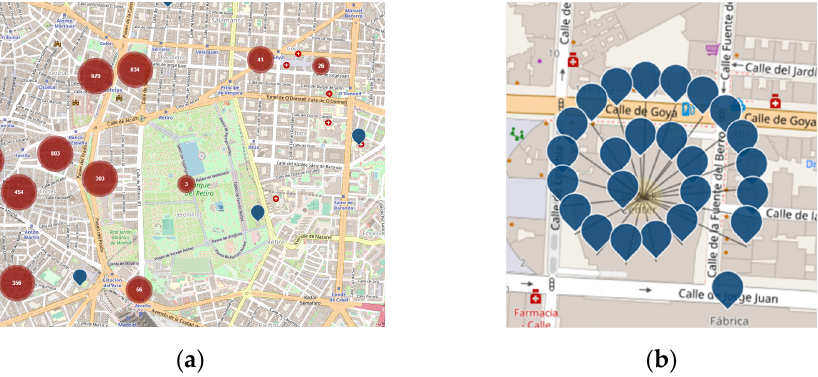
Figure 4. Markers, where: ( a ) example of clusters (small, medium, and large markers) and a single object (in blue); ( b ) example of accessing a cluster of 24 objects.